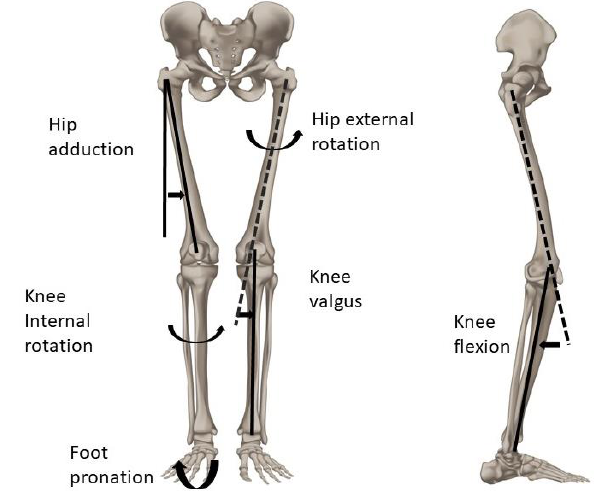
Figure 2. Diagrammatic representation of the joint angle measurements.